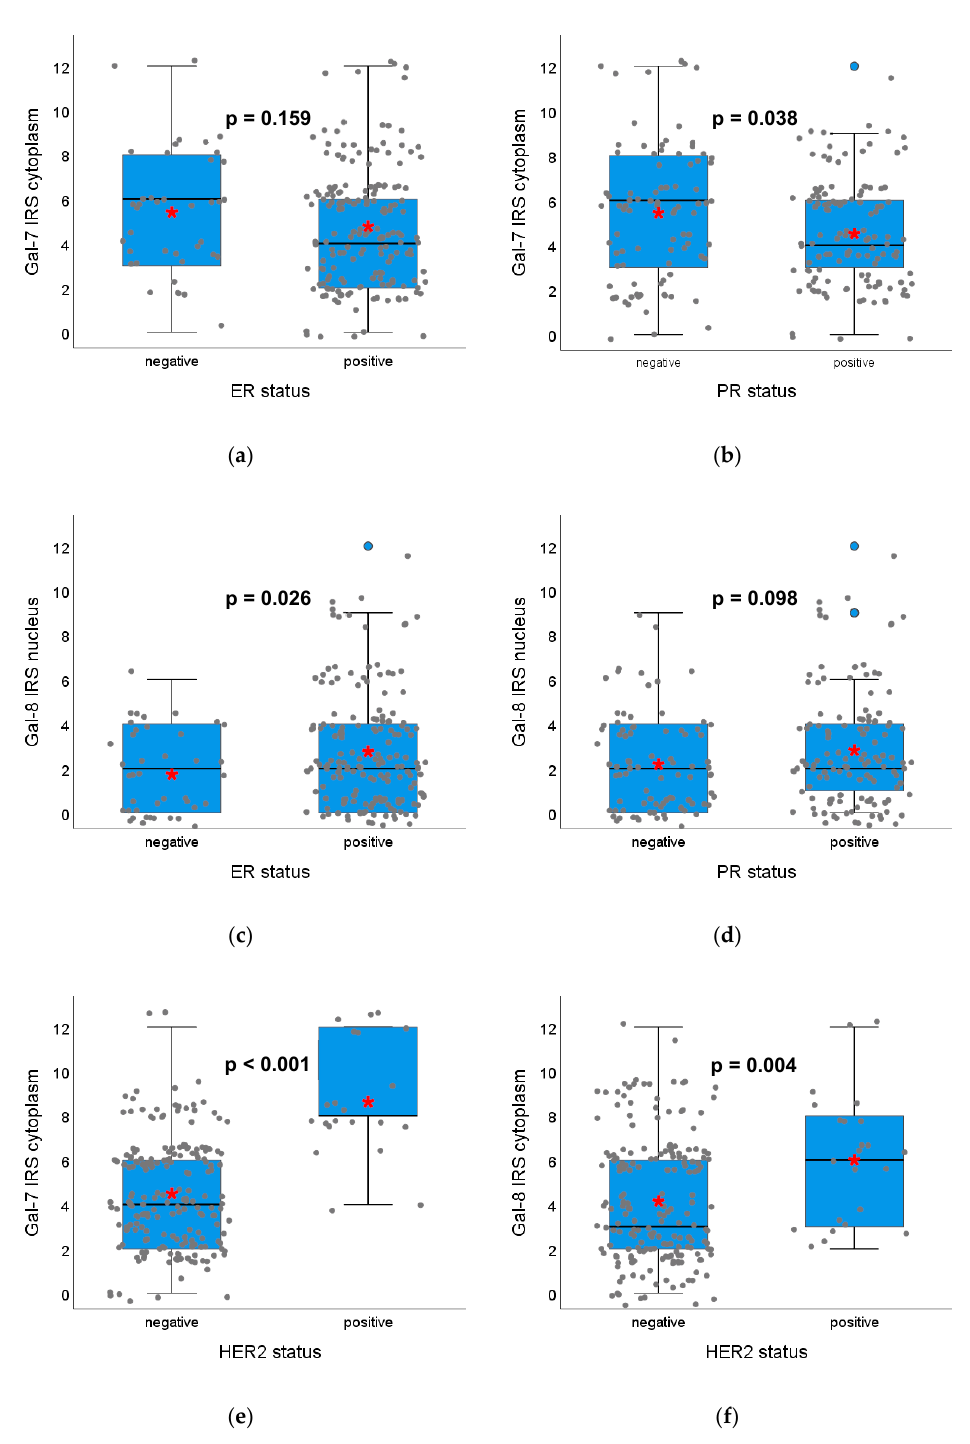
Figure 3. Association of Gal-7 and Gal-8 expression with the ER-, PR- and HER2-status. Boxplots of the median IRS of Gal-7 staining in the cytoplasm dependent on ER-status ( a ), PR-status ( b ) and HER2-status ( e ) and of Gal-8 staining in the nucleus dependent on ER-status ( c ) and PR-status ( d ) as well as Gal-8 staining in the cytoplasm dependent on HER2-status ( f ) are shown. ER-positive tumors do not di ff er concerning Gal-7 staining but show a higher Gal-8 staining. PR-positive tumors show lower Gal-7 staining and a trend towards higher Gal-8 staining. HER2-positive tumors show a significantly higher Gal-7 and Gal 8 expression in the cytoplasm compared to HER2-negative tumors. Staining in the nucleus does not show significant di ff erences. Red asterisks indicate means. Please note that individual data points have been jittered to avoid